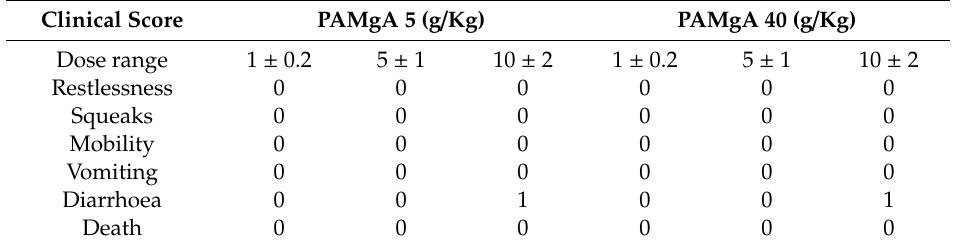
Table 4. Clinical response after 24 h of oral administration of both PAMgA 5 and PAMgA 40 at doses between 1–10 g / kg.